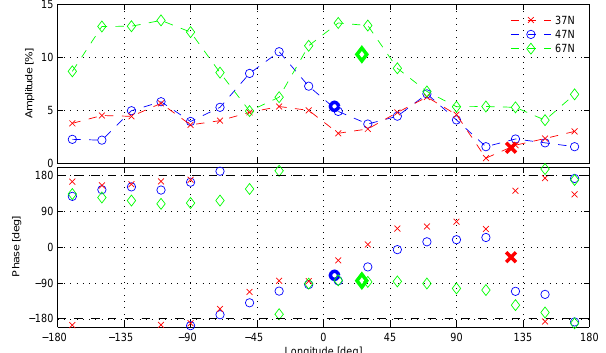
Figure 6. Amplitudes (top panel) and phase (bottom panel) of the 20-day wave in water vapor on 0.05hPa as observed by Aura MLS and the three ground-based microwave radiometers during boreal winter 2011/2012. The bold symbols are from the ground-based radiometers (Bern at 7.5 ◦ E, Sodankylä at 26.6 ◦ E and Seoul at 127 ◦ E), and the thin symbols connected with dashed lines are from Aura MLS at the latitudes of the ground-based microwave radiome- ters (37 ◦ N for Seoul, 47 ◦ N for Bern and 67 ◦ N for Sodankylä).